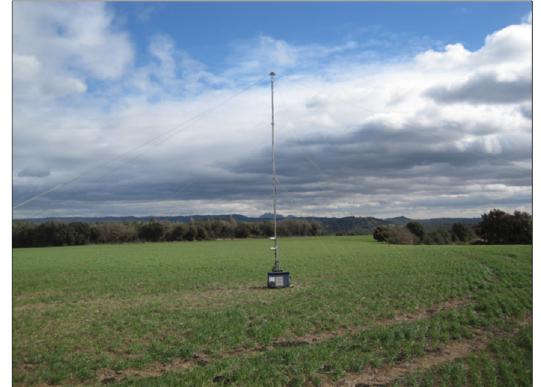
Figure 8. The central sensor system in in Sant Martí Sesgueioles.